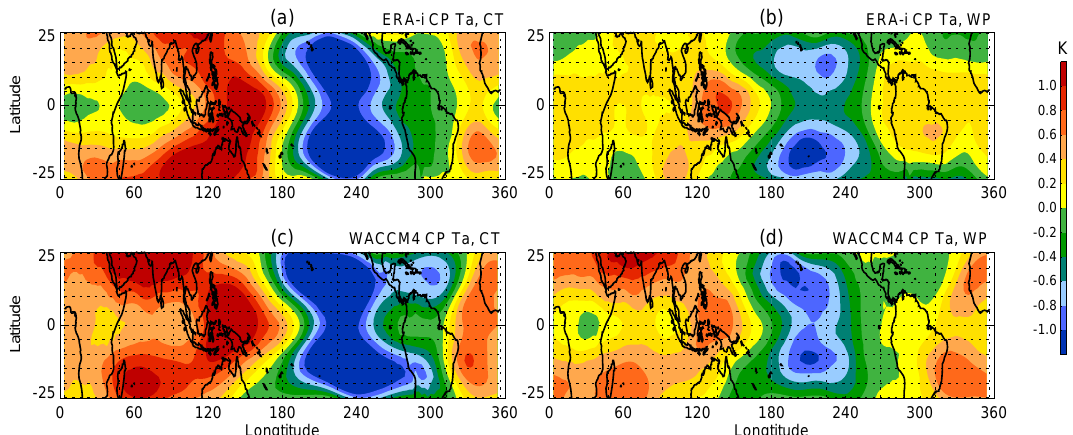
Fig. 5. Cold point temperature anomalies in the tropopause based on composite ERA-Interim data, 1979–2010: (a) canonical El Ni˜no events, and (b) El Ni˜no Modoki events. Anomalies in cold point tropopause temperatures, for R2–R1 (c) and R3–R1 (d) . Contour intervals, ± 0.2K.